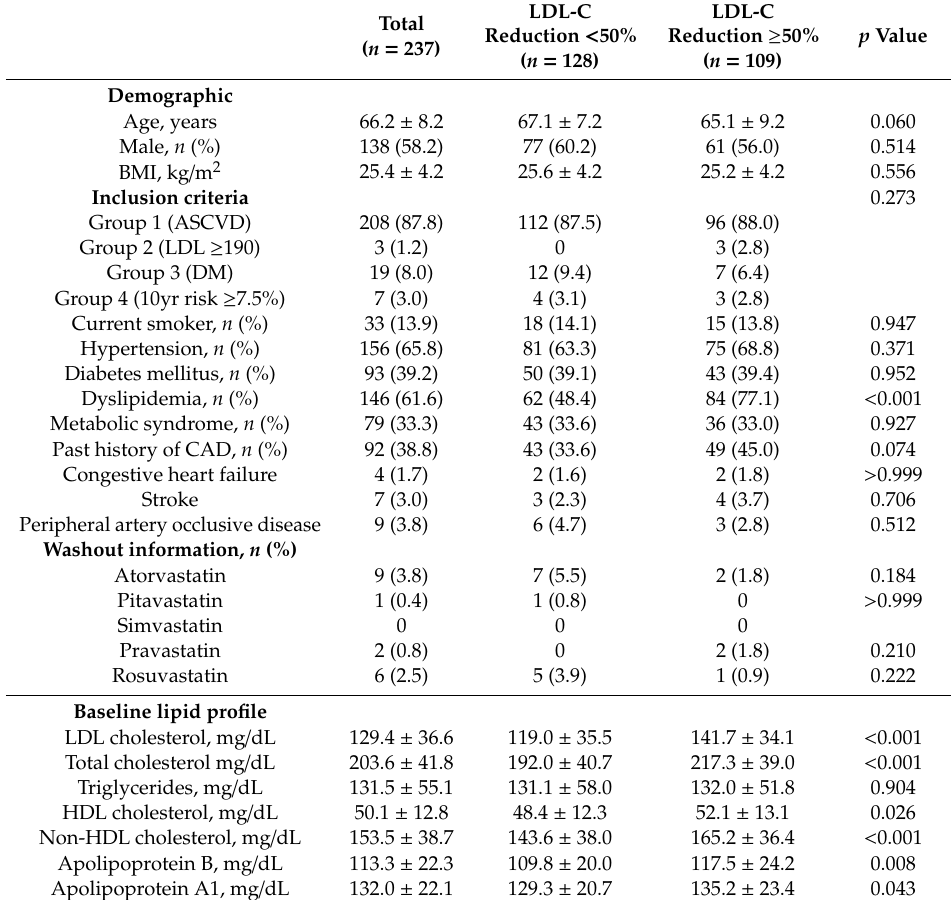
Table 3. Comparison of subjects who reached 50% LDL cholesterol reduction versus others.